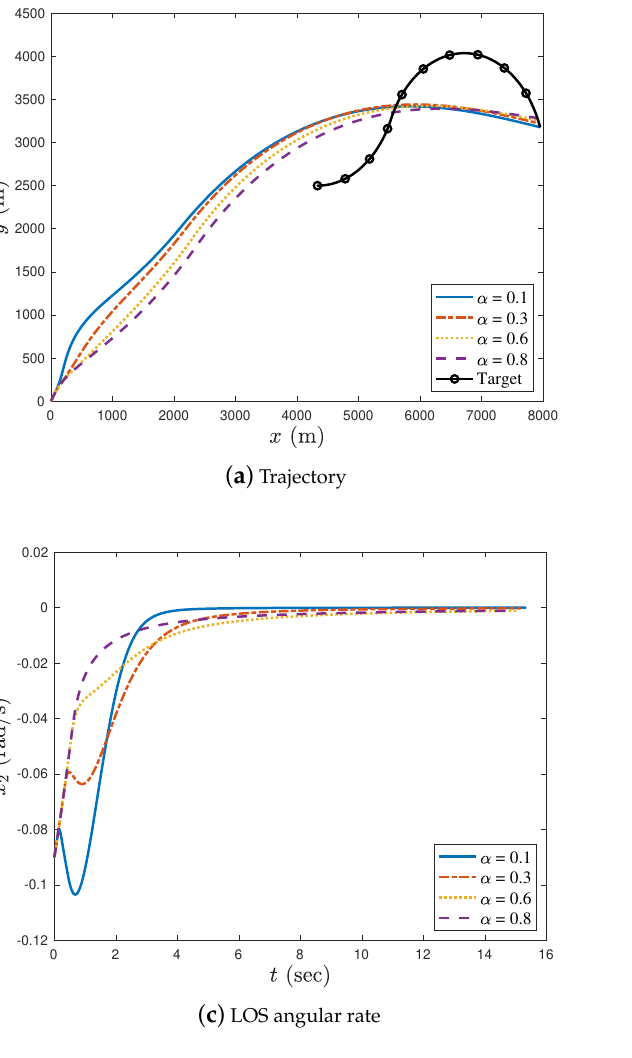
Figure 5. Simulation results with α = 0.1,0.3,0.6,0.8 in case